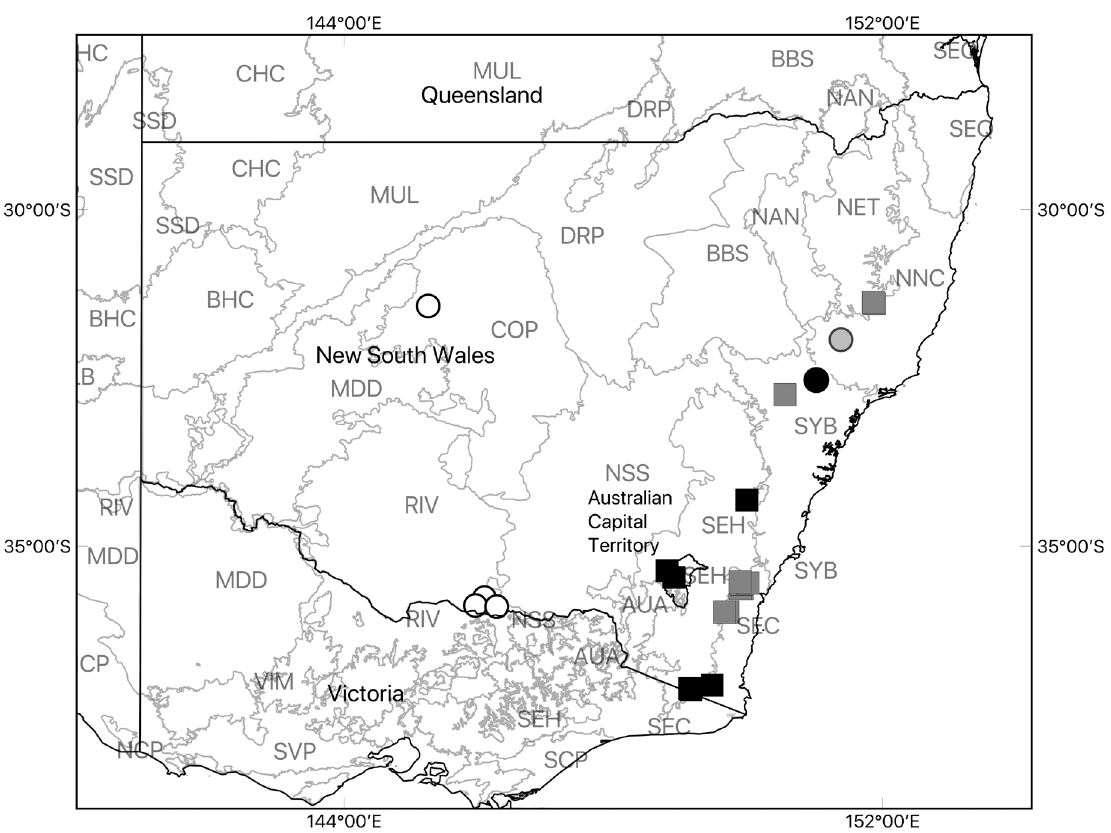
Figure 15. Distribution records of Artoria comleroi sp. n. (full circle), A. corowa sp. n. (open circles), A. equipalus sp. n. (grey circle), A. extraordinaria sp. n. (grey squares) and A. flavimana Simon, 1909 (full squares) in NSW and ACT. IBRA bioregions